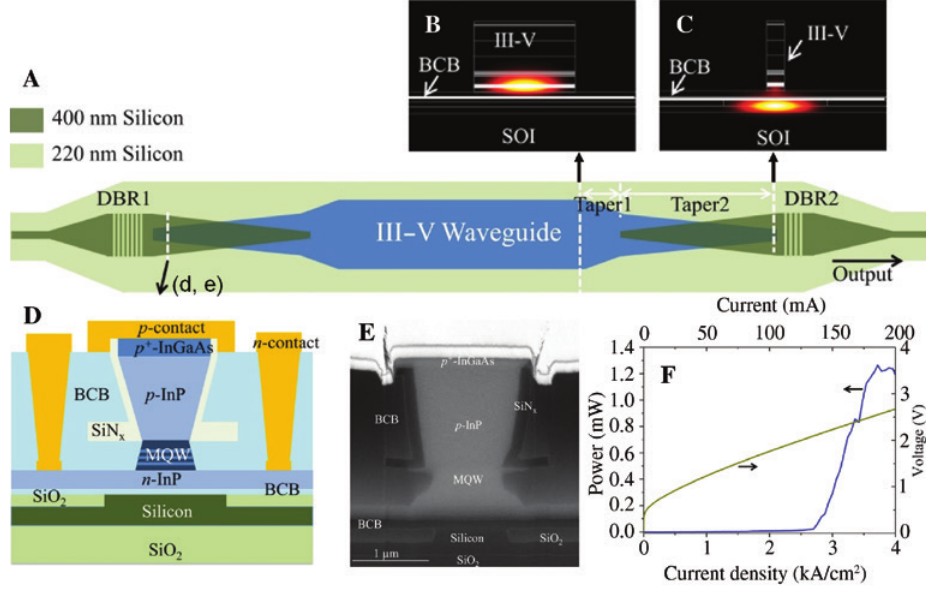
Figure 5: Heterogeneously integrated 2.3- μ m laser. (A) Top-view schematic depicting the heterogeneously integrated 2.3- μ m laser layout; (B, C) optical modal profiles at different locations inside the laser cavity, the respective locations are marked with arrows in (A); (D) schematic and (E) SEM image showing the cross-sectional structure of the laser at the location marked with an arrow in (A); (F) measured output power and voltage versus injection current density of the laser [76] (© 2016 Optical Society of America).